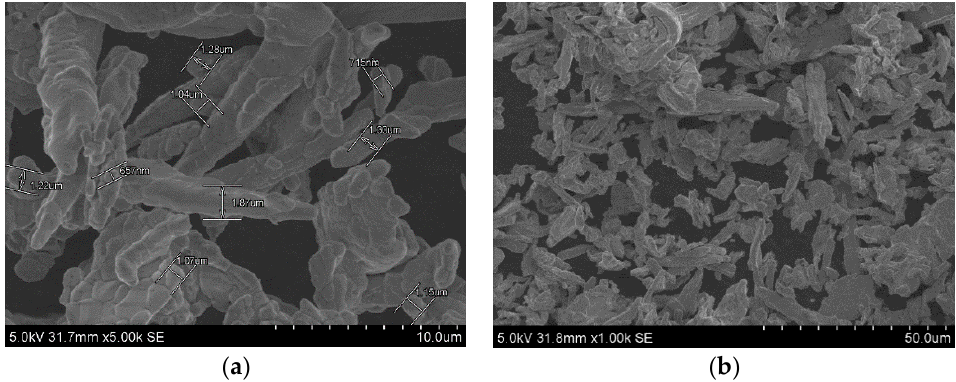
Figure 2. SEM images of electrolytic iron powder with a rod-like structure with irregular shape and surface; ( a ) electrolytic iron (EI) particles shape and size, ( b ) particles coated with guar gum.